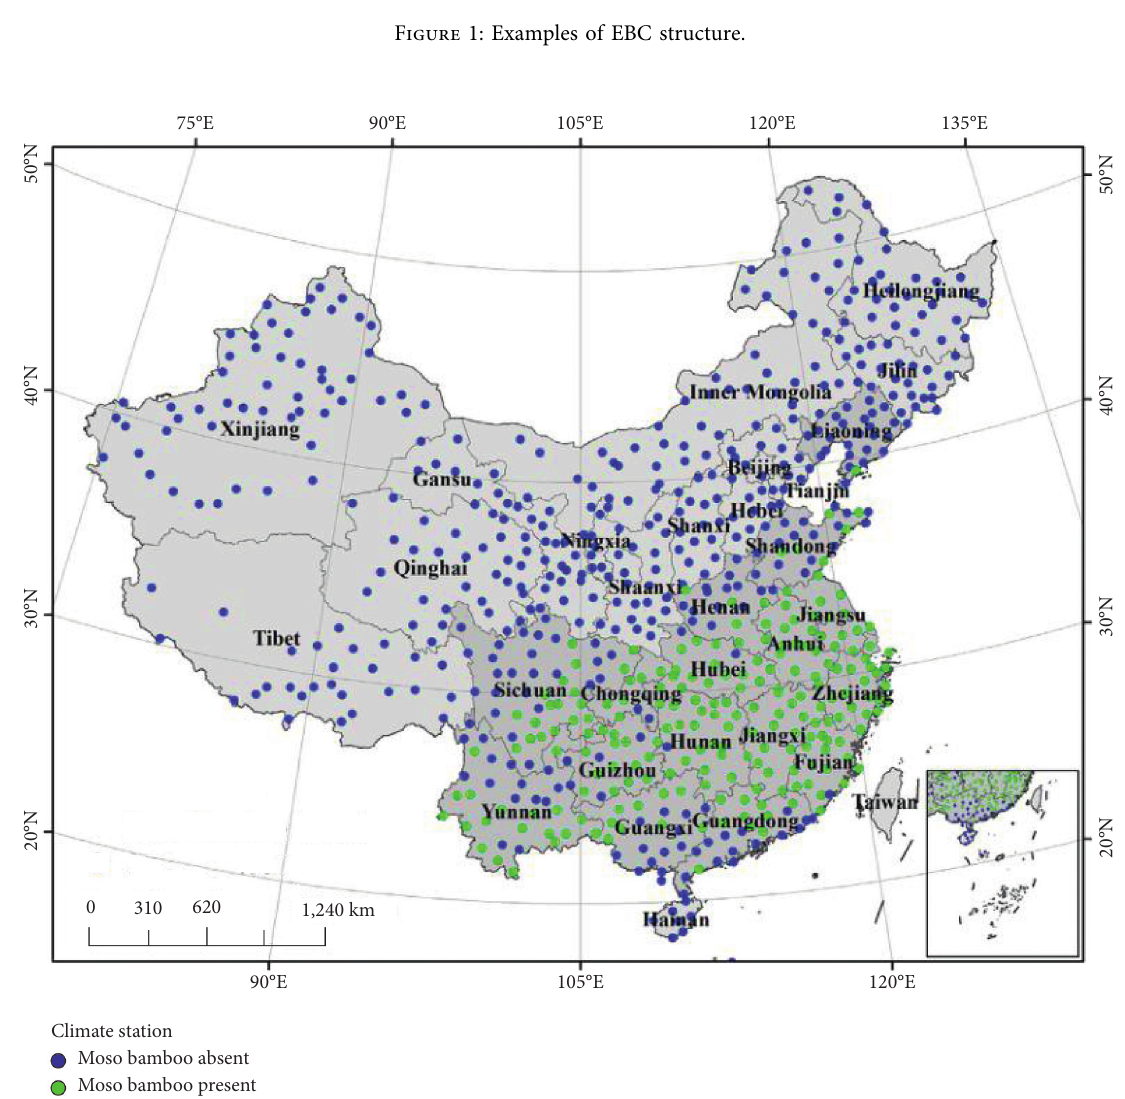
Figure 2: The information on the distribution of Moso bamboo in Mainland China by Shi